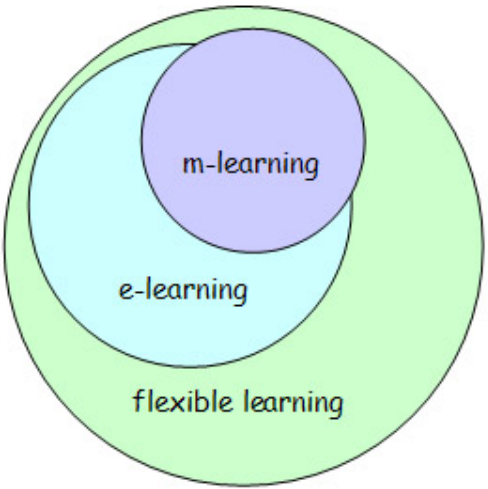
Figure 1. The ‘just enough, just in time, just for me’ model of flexible learning (Peter,